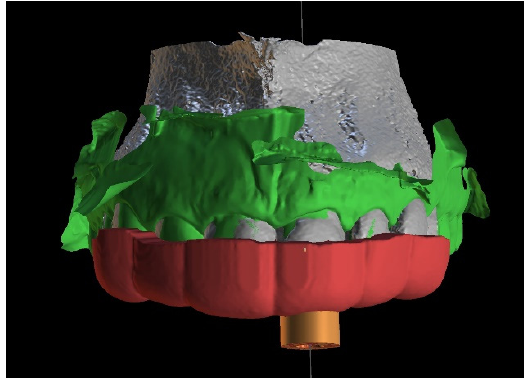
Figure 4. Figure showing extent of the guide.